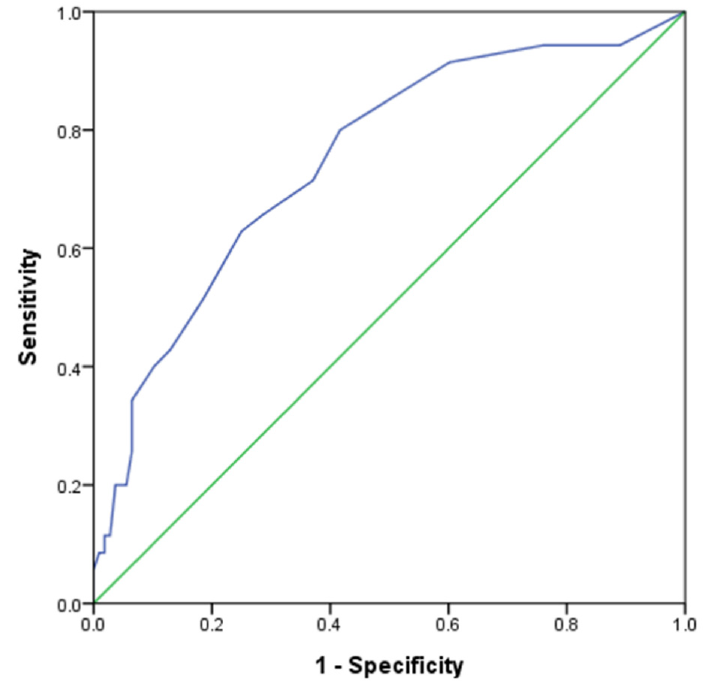
Figure 1. The receiver operating characteristic (ROC) curve associated with the discrimination of dermatology life quality index (DLQI) score on positive SF-36-based mental stress. Note: Positive SF-36-based mental stress was defined as the score of SF-36 mental health domain ≤ 52. The area under ROC curve was 0.749 (95% CI: 0.655–0.844), p < 0.05. The cutoff point of DLQI was 7.